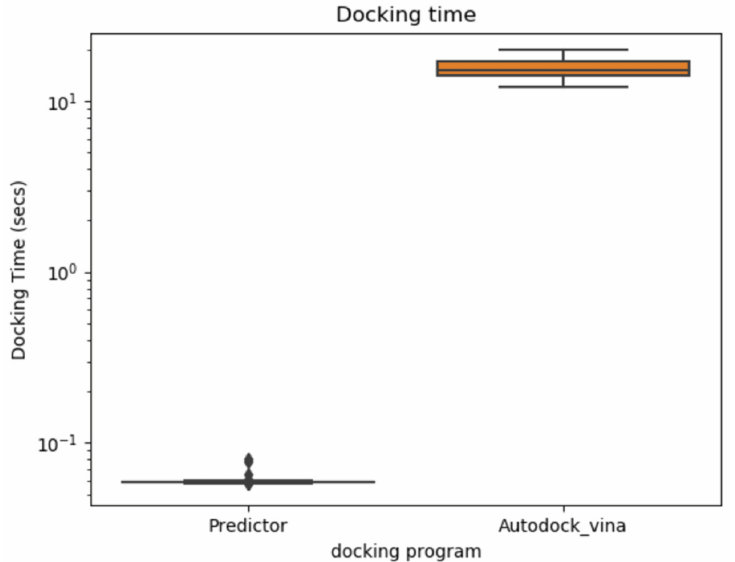
Figure 2. Comparison of computational times of docking energy calculations with Autodock Vina and the prediction